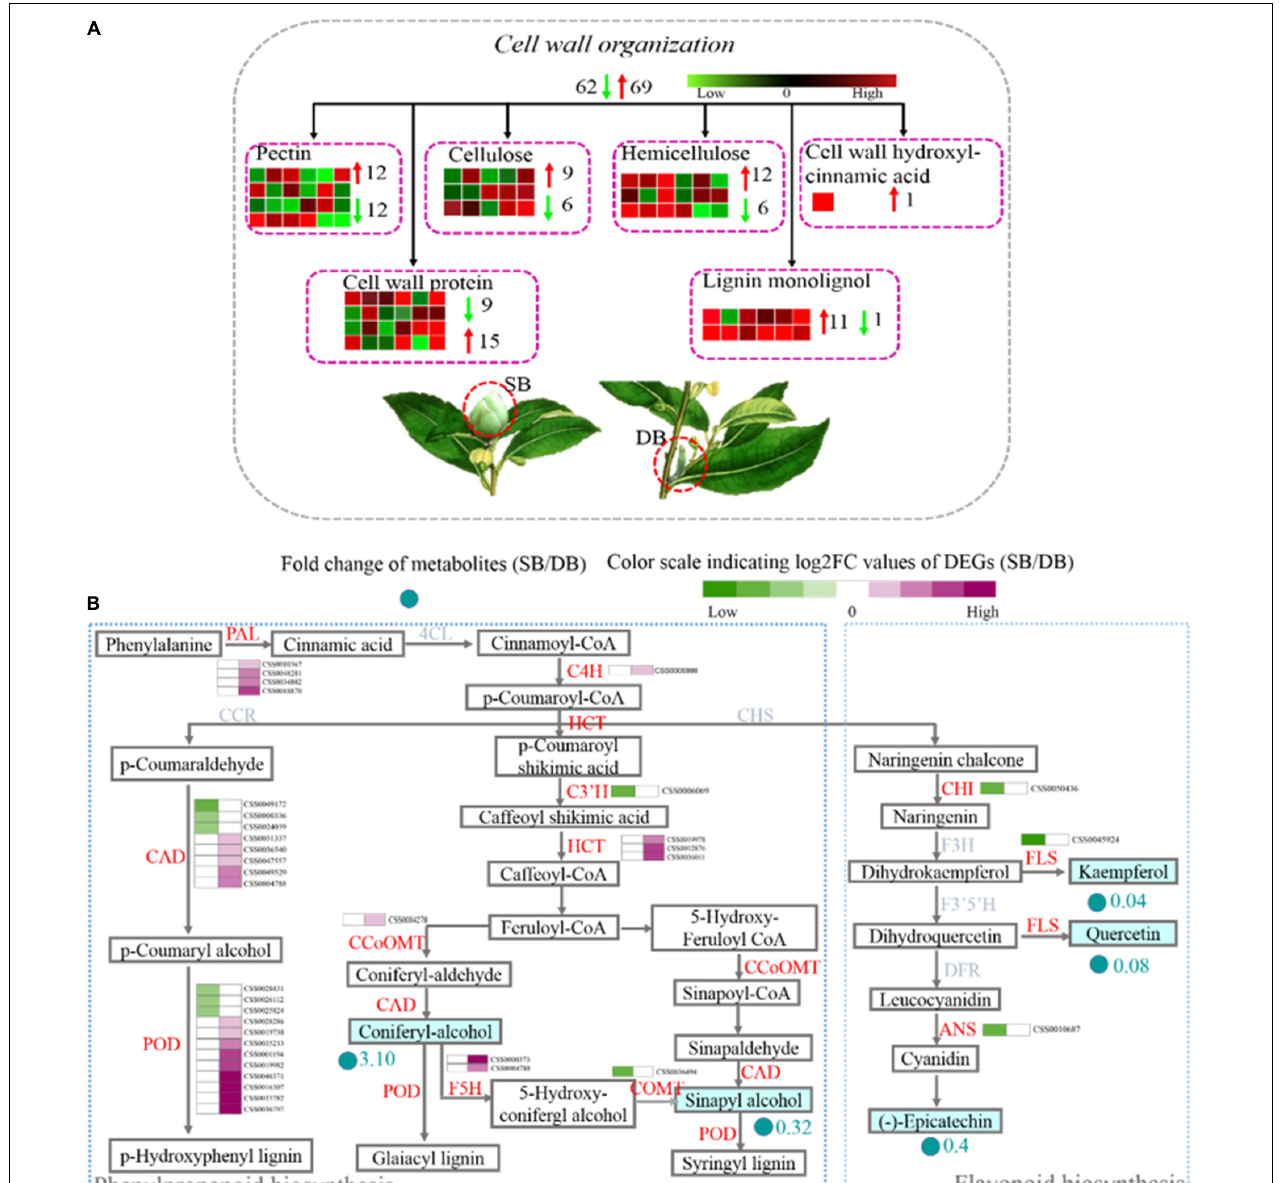
FIGURE 7 | (A) Distribution of DEGs related to cell wall metabolism by Blast. (B) Expression profile of DEGs related to the phenylpropanoid and flavonoid biosynthesis pathways in SB and DB tissues. PAL, phenylalanine ammonia-lyase; C4H, trans- Cinnamate 4-hydroxylase; HCT, shikimate O-hydroxycinnamoyltransferase; CCOMT, caffeoyl-CoA O-methyltransferase; CAD, cinnamyl-alcohol dehydrogenase; CHI, chalcone isomerase; FLS, flavonol synthase; ANS, anthocyanidin synthase; COMT, caffeic acid 3-O-methyltransferase; F5H, ferulate-5-hydroxylase. Detailed annotation information of cell wall metabolism was shown in Supplementary Table 6 . Detailed annotation information of DEGs related to phenylpropanoid and flavonoid metabolisms was shown in Supplementary Table 7